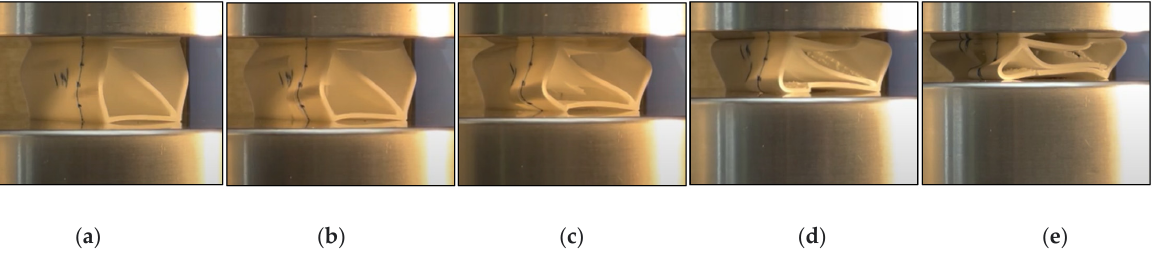
Figure 12. Experimental compression test of novel cell under lateral load. ( a ) Wall buckling; ( b ) Mid- section fracture; ( c ) Lower plateau ( d ) Upper plateau; and ( e ) Beginning of densification.